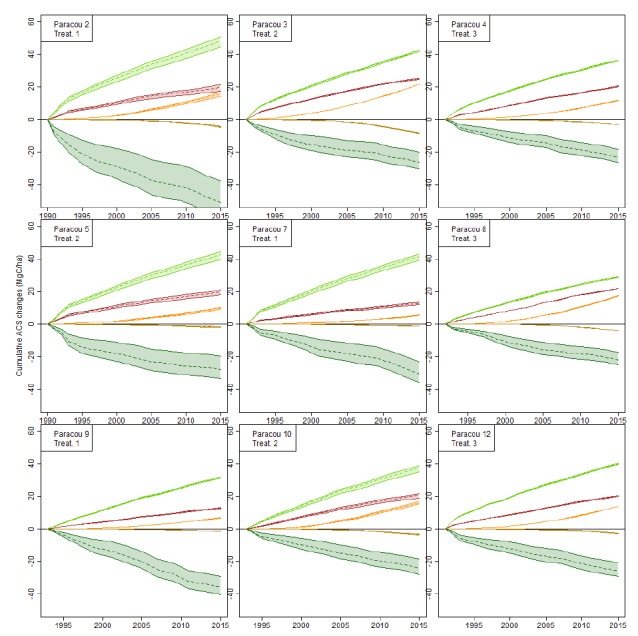
Effect of botanical indetermination on cumulative ACS changes in the 9 Paracou forest plots.Wood density of all undetermined trees is set to 0.4 (lower bound), 0.9 (higher bound), or the plot average wood density (dashed lines): the latter is the method used in the study. Cumulative ACS changes are then calculated. Cumulative ACS changes (MgC/ha) are: survivors’ ACS growth (light green), survivors’ ACS loss (dark green), new recruits’ ACS (red), recruits’ growth (orange), recruits’ ACS loss (ocher).